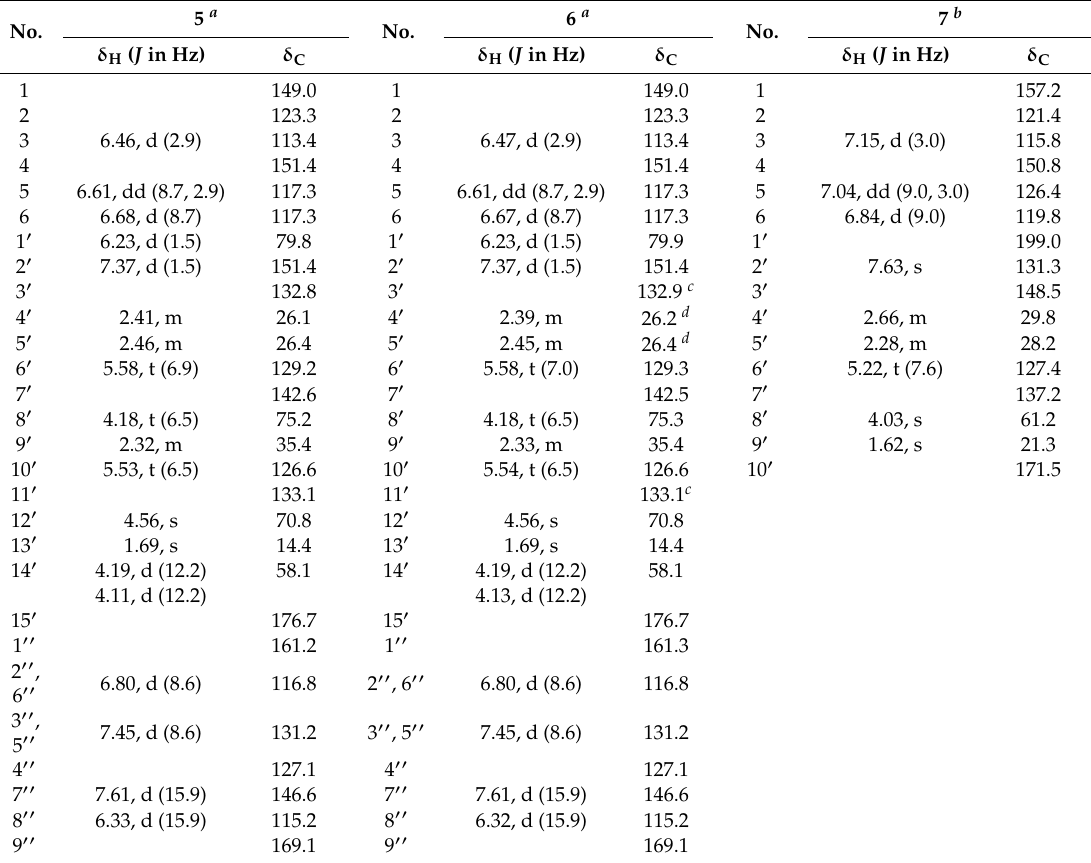
Table 3. 1 H- and 13 C-NMR data of 5 – 7